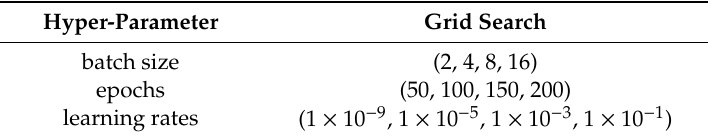
Table 2. Table 2. Hyper-parameters.